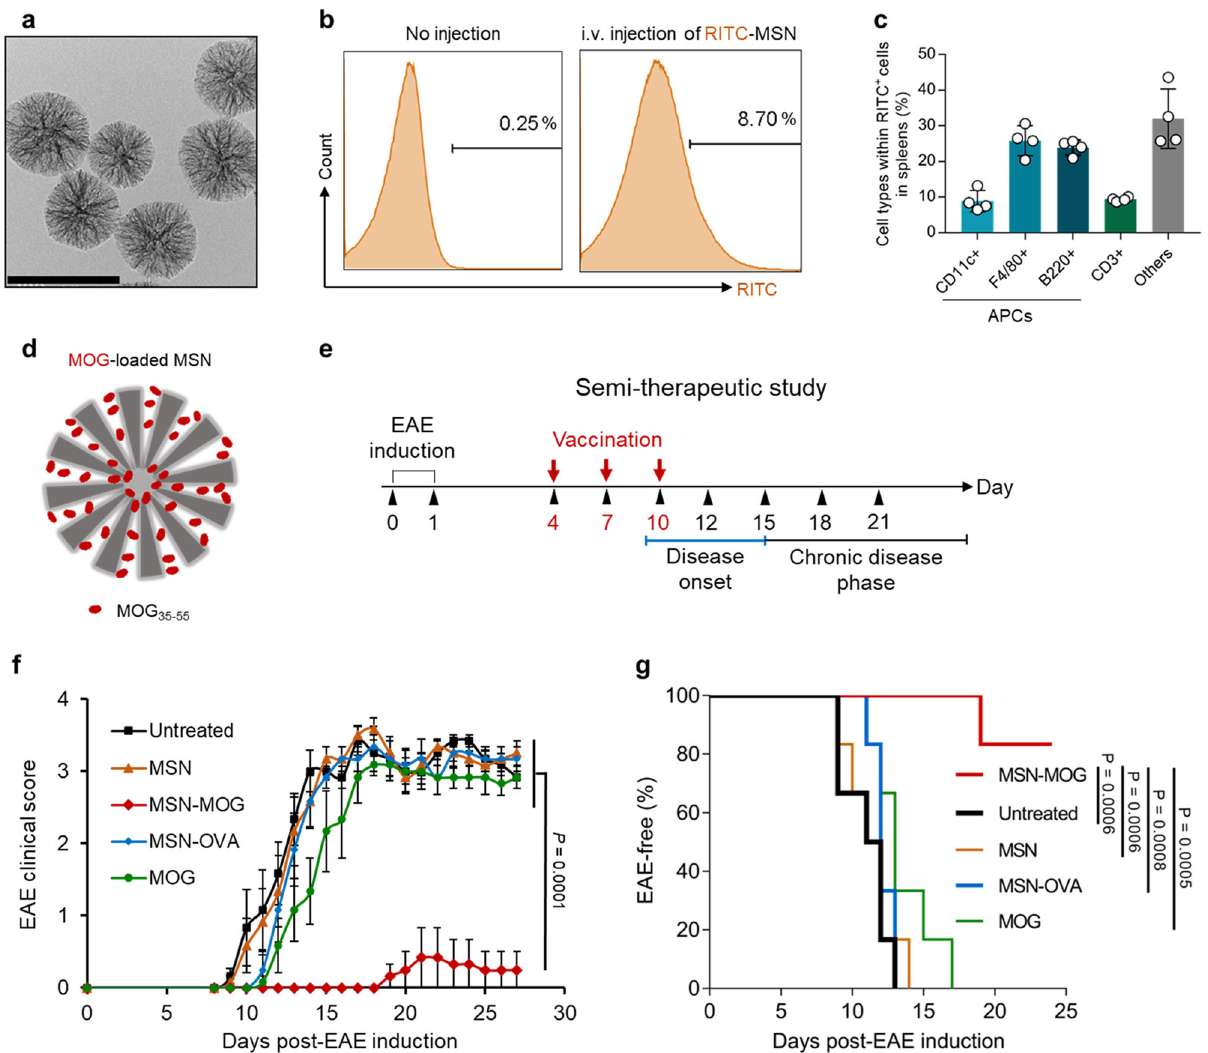
Fig. 1 | Intravenous injection of myelin oligodendrocyte glycoprotein (MOG)- loadedMSNssuppressedEAEdevelopment.a Transmissionelectronmicroscopy (TEM) image of MSNs, scale bar: 200nm; the experiment was repeated indepen- dently at least three times. b Representative histograms of rhodamine B iso- thiocyanate (RITC) signal from splenocytes of C57BL/6 mice that were left untreated(noinjection)orintravenouslyinjectedwithRITC-MSNs24hbefore fl ow cytometry analysis. c Percentage of immune cells that engulfed RITC-MSNs in spleens, n =4 biologically independent animals. d Schematics for MOG loading in MSNs. e EAEwasinducedinC57BL/6micebeforebeinginjectedintravenouslywith